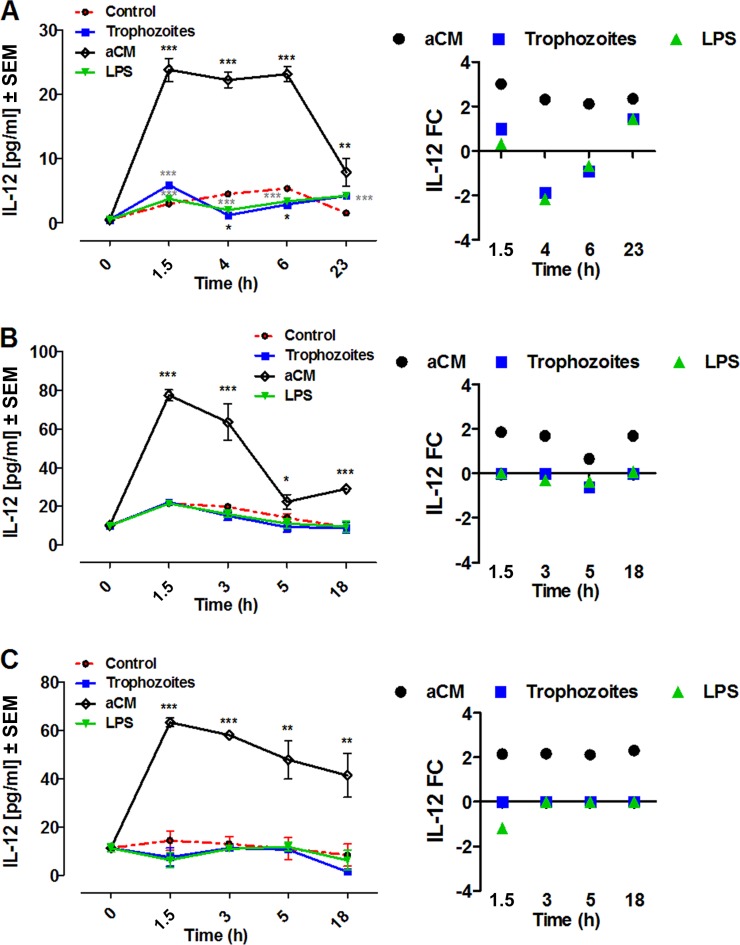
IL-12 production by THP-1 (A), PBMCs (B), and MDMs (C) after coincubation with trophozoites of A. castellanii (trophozoites) or stimulation with aCM. A total of 2 × 105 of either target cells were challenged with either 2 × 104 trophozoites, ratio of 10:1, or with 800 μl of aCM (final dilution of 4:5 in the culture medium). IL-12 concentration in THP-1 experimental supernatants was evaluated at 1.5, 4, 6, and 23 h poststimulation, whereas in both PBMCs and MDMs experimental supernatants it was evaluated at 1.5, 3, 5, and 18 h poststimulation. All three cellular models were stimulated with 10 ng/ml LPS as a positive control, whereas unstimulated cells (control) were considered the negative control. Experiments were performed in triplicate and repeated at least 3 times. Results represent the mean values ± SEM of either n = 5 (THP-1) or n = 3 (PBMCs and MDMs) samples. One-way ANOVA was applied for each time points. Dunnett's multiple-comparison test was performed to evaluate differences between the experimental condition means and the control at each time point. In the graphs, significance between the experimental conditions and the control are indicated as P values of <0.05 (*), <0.005 (**), and <0.0001 (***). Student t test was also applied at each time point to verify the significance of single pairs of means (single experimental condition versus control). In the graphs, significances between the experimental condition and the control, obtained with Student t test, are indicated as a P value of <0.0001 (***). On the right, the same results are expressed as fold change (FC) over the unstimulated cells.